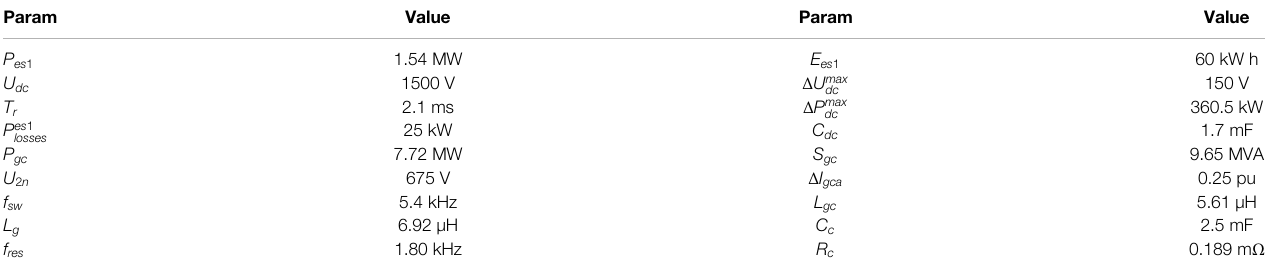
TABLE 2 | Summary of the ESS parameters obtained using the proposed procedure.